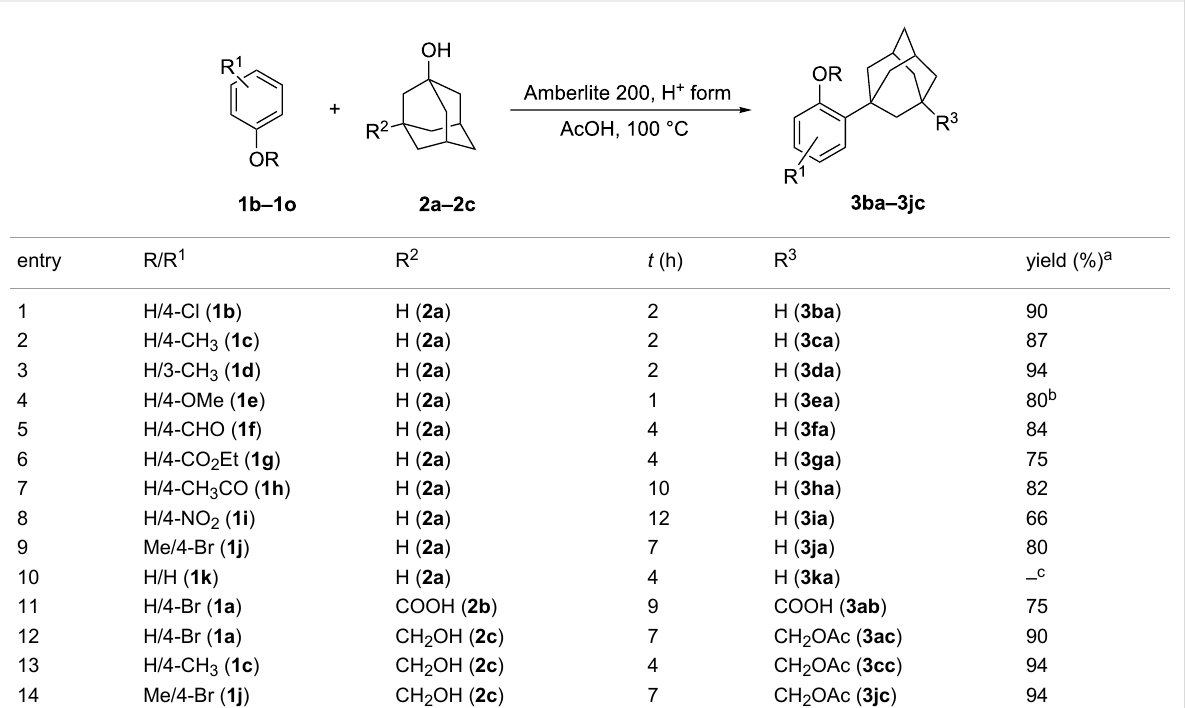
Table 2: Scope of the ion-exchange-resin catalyzed